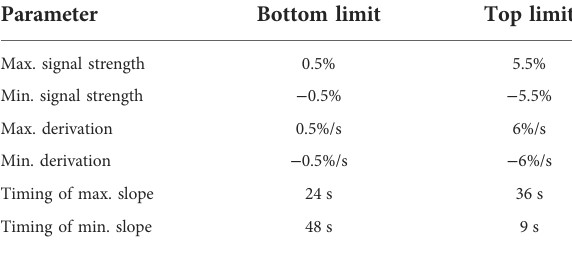
TABLE 1 Limits for each